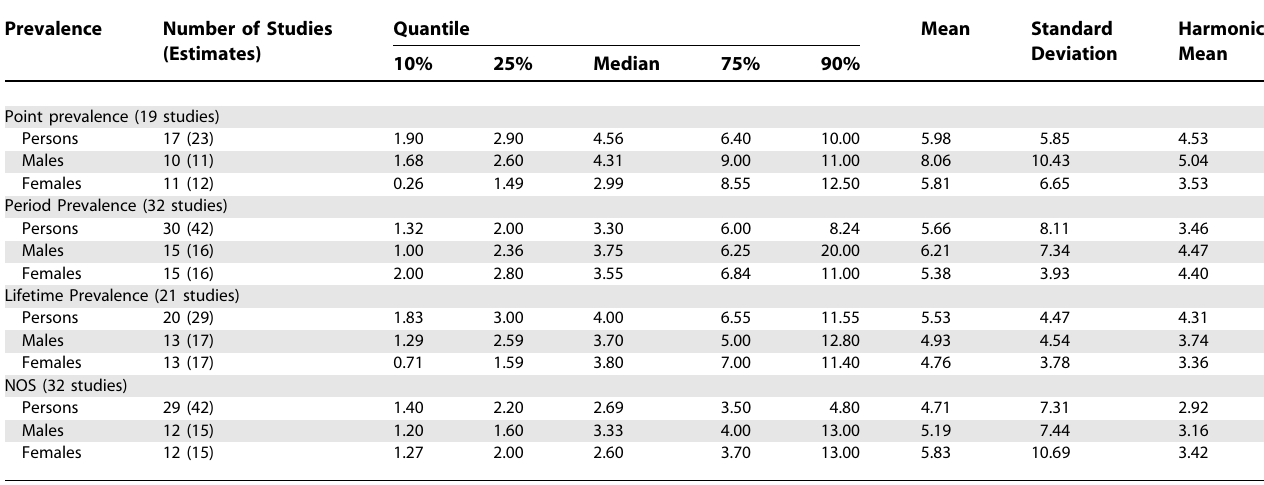
Table 5. Quantiles and Moments of Point, Period, Lifetime, and NOS Prevalence per 1,000 by Sex Prevalence Number of Studies